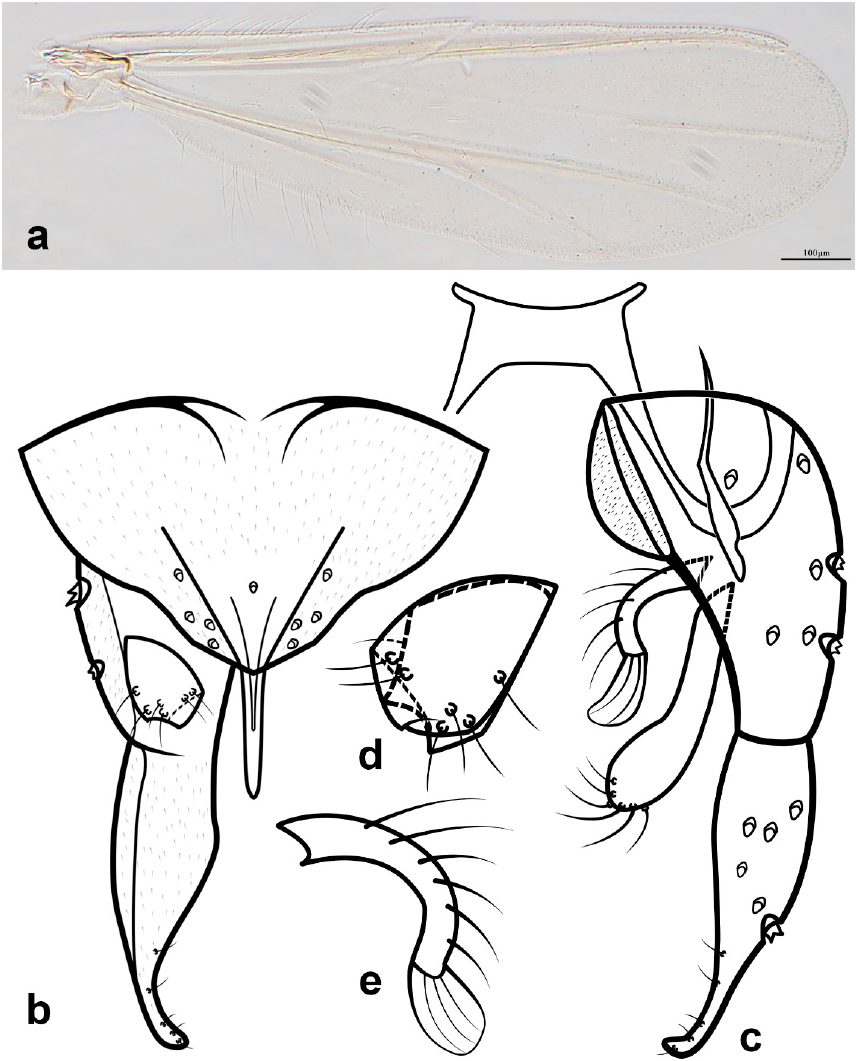
Figure 5. Rheotanytarsus fluminis: ( a ) wing; ( b ) hypopygium, dorsal view; ( c ) hypopygium, ventral view; ( d ) superior volsella; ( e ) median volsella.